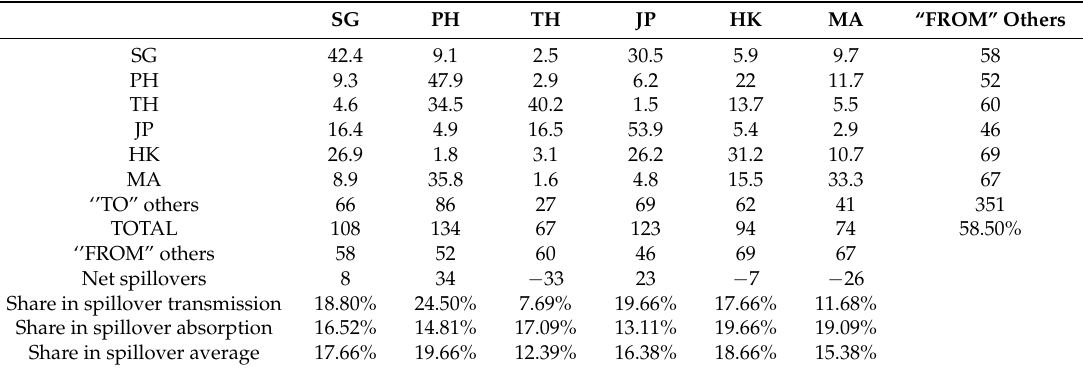
Table 8. Generalized P/NAV spillovers across Asia real estate stock markets: eight-step forecast horizon, VAR (1), 2004Q1 to